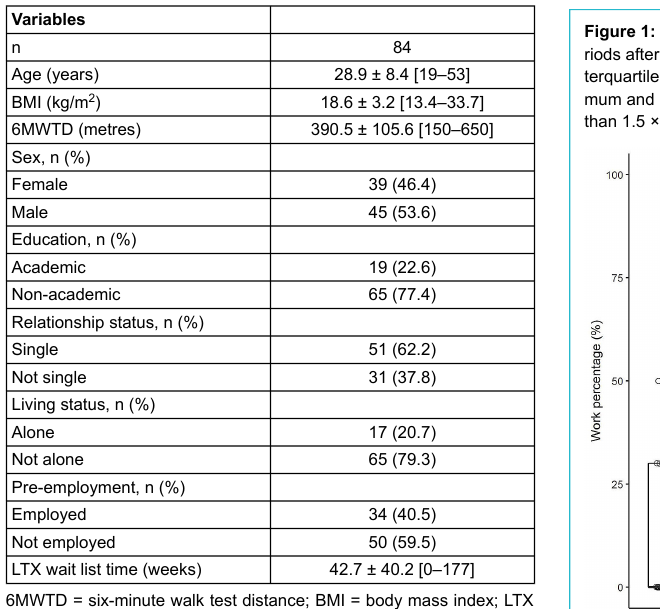
Table 1: Characteristics of individuals at the time of listing for lung transplantation.